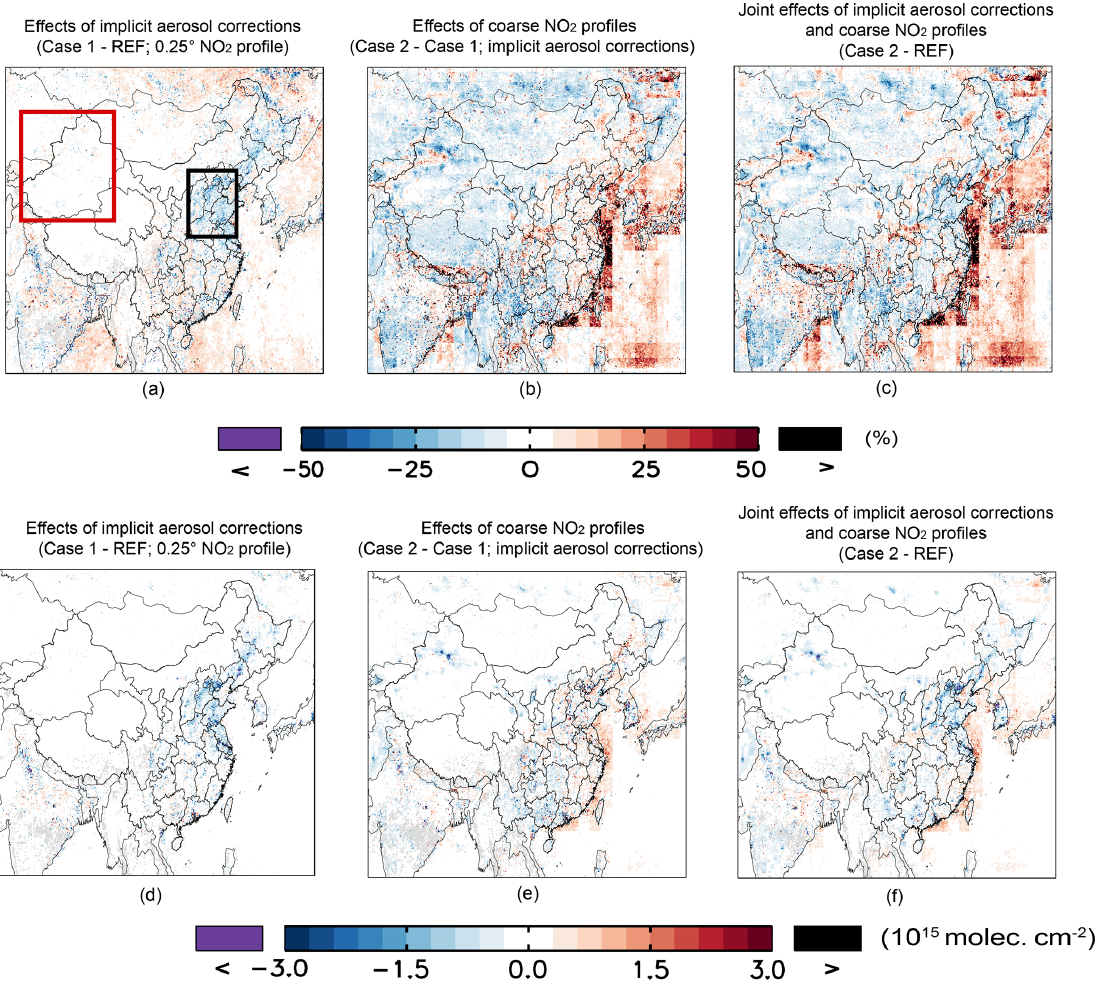
Figure 7. (a–c) Relative differences caused by aerosol corrections and a priori NO 2 profiles. Panels (d) – (f) are the corresponding absolute differences. The black and red rectangles stand for northern Eastern China and Xinjiang,